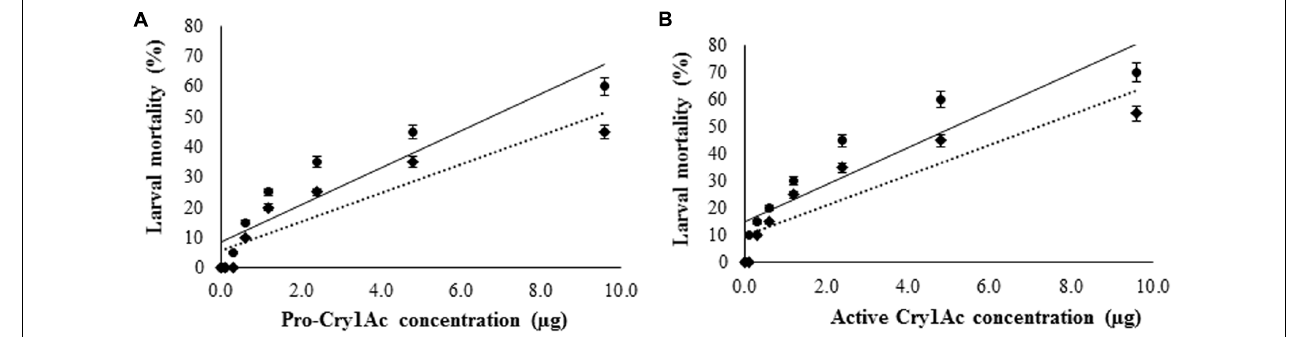
FIGURE 6 | Effect of Cry1Ac on larval survival. The early fourth-instar larvae were used for bioassay. The larvae were reared on (A) pro-Cry1Ac and (B) active Cry1Ac (formed after the processing of pro-Cry1Ac by gut bacterial proteases) toxin treated artificial diet. ( • ) mortality percent in larvae reared on toxin treated artificial diet and ( (cid:169) ) mortality percent in larvae reared on artificial diet treated with both toxin and antibiotic cocktail. To eliminate gut bacteria the larvae were reared on diet treated with 100 µ l of antibiotic cocktail (stock: 1 mg/ml of each antibiotic) per gram diet till fourth-instar, and then reared on antibiotic cocktail containing diet treated with toxin. There were three replications for each treatment and 10 larvae in each replication in a completely randomized design (CRD). Each value represents the average of three experiments.